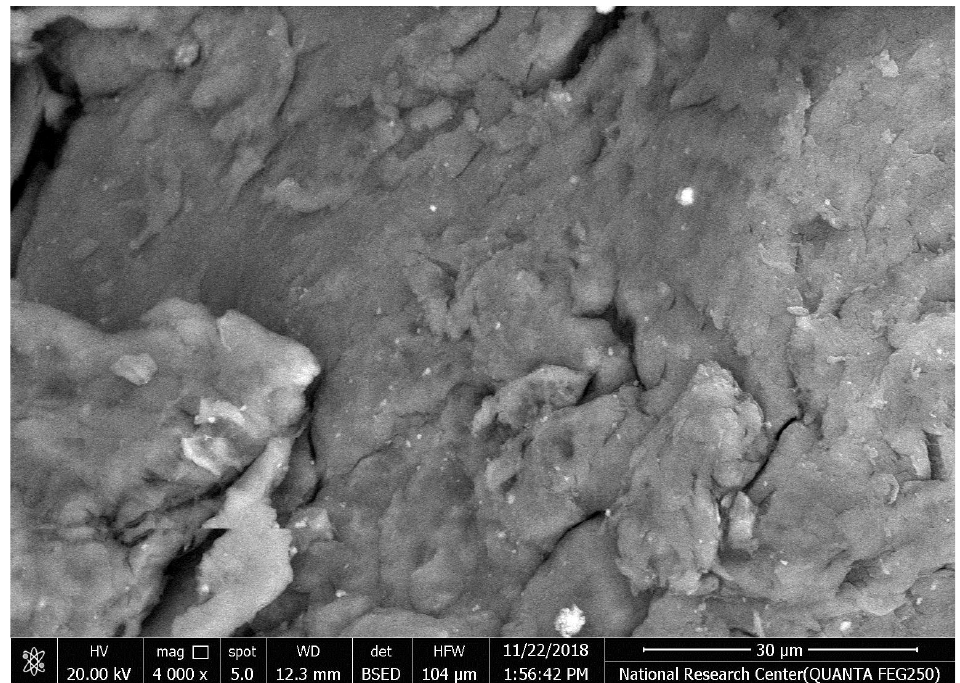
Figure 2. The morphology of chitosan nanoparticles powder by Scanning electron microscopy (SEM) image of chitosan.